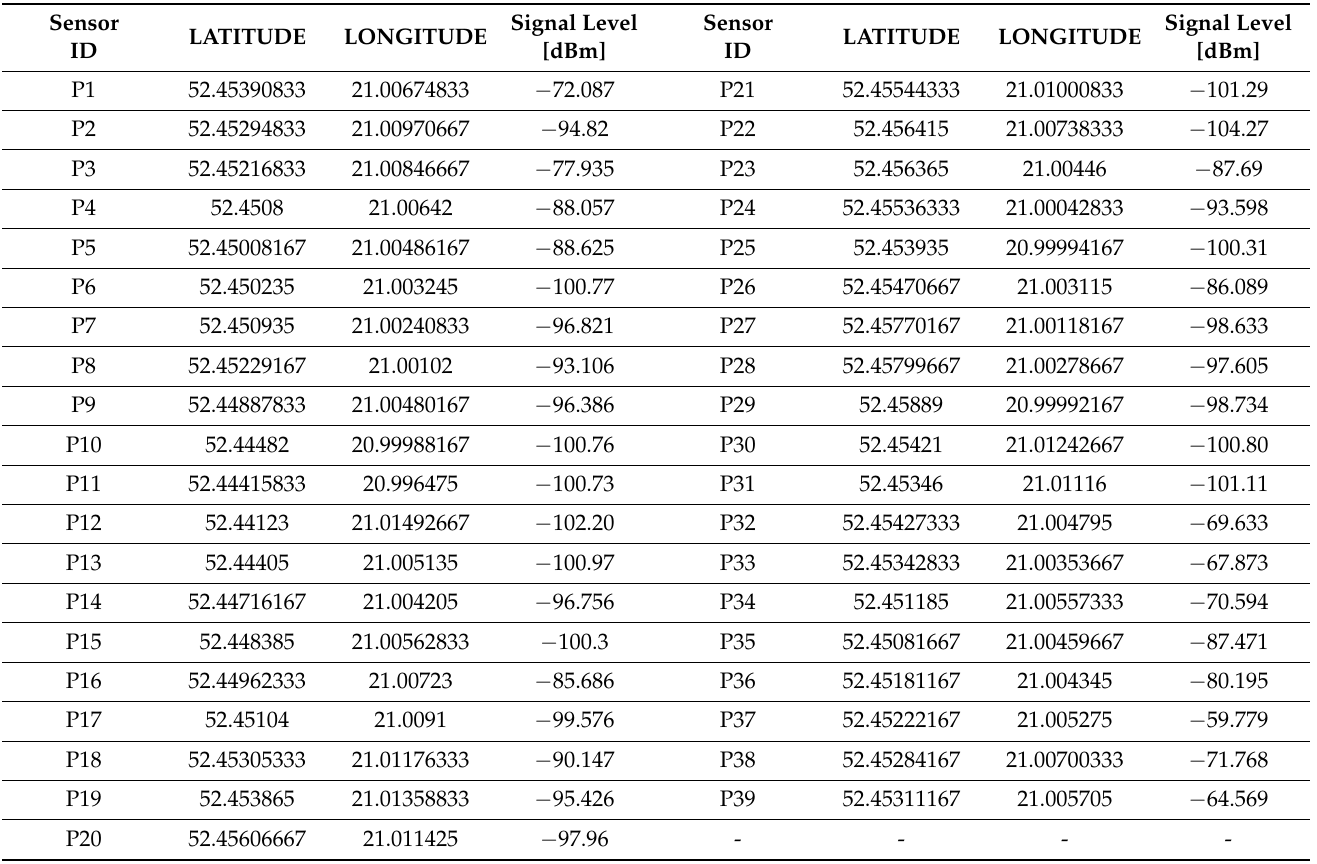
Table A1. Results of